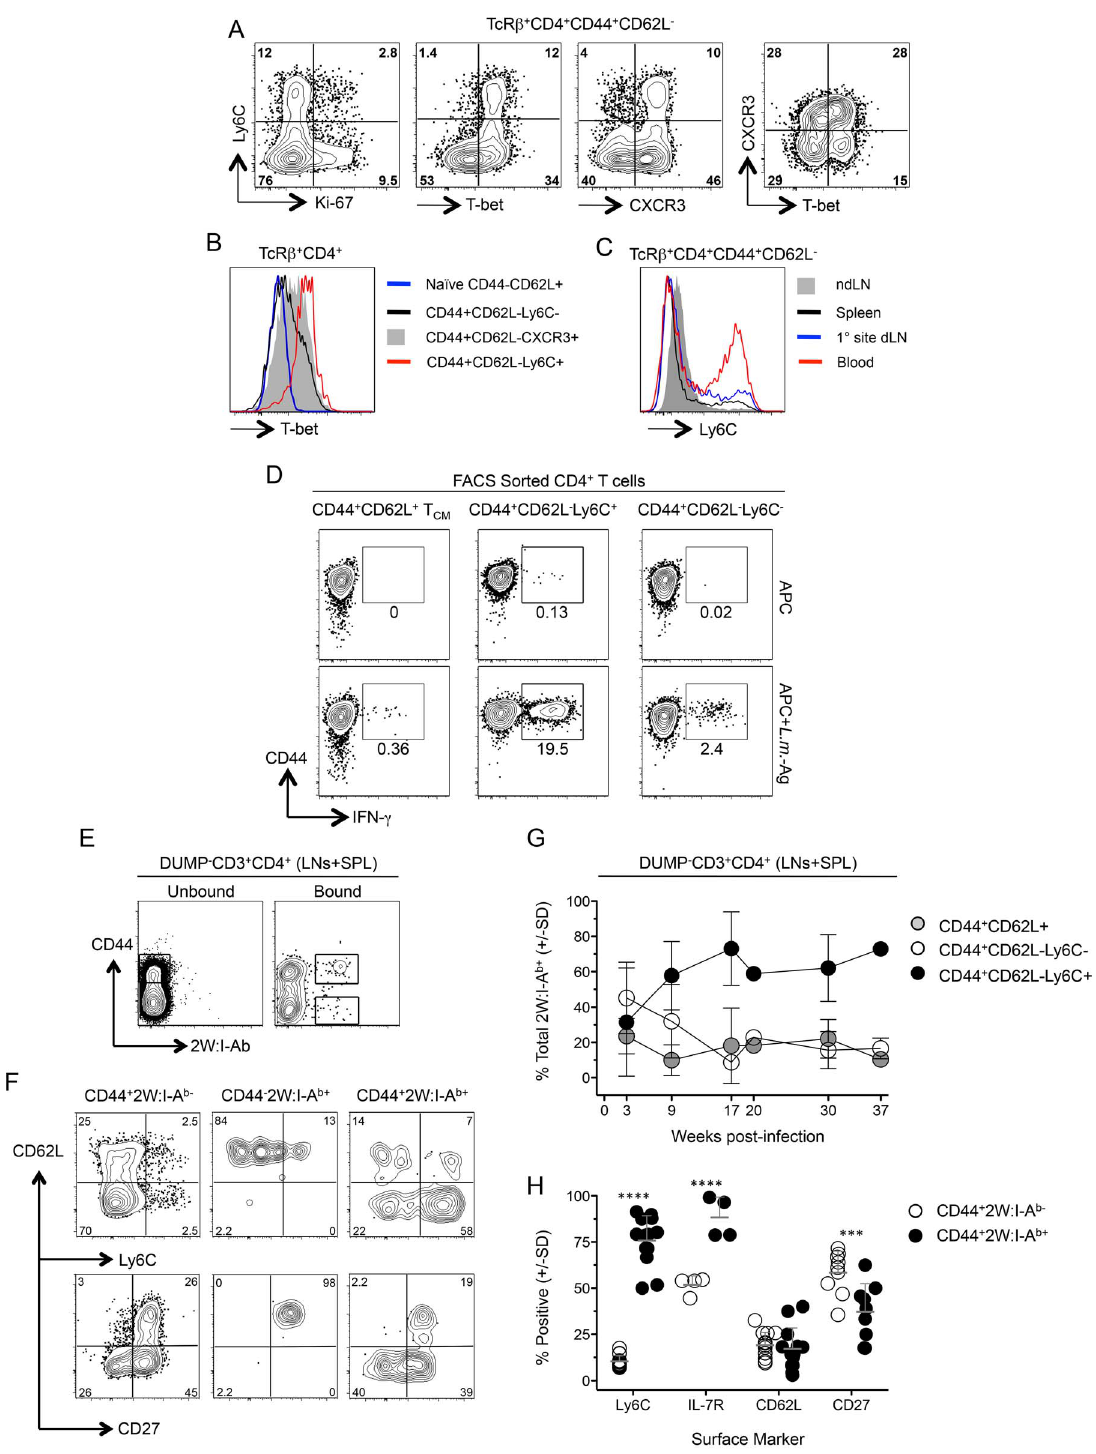
Figure 6. Ly6C hi T-bet hi CD4 + T cells exist prior to challenge and are the predominant phenotype of antigen-specific cells during chronic infection. ( A ) Representative FACS plots of Ly-6C, T-bet, Ki-67 and CXCR3 expression by polyclonal TCR b + CD4 + CD44 + CD62L 2 cells from the spleens of chronic mice. ( B ) Analysis of T-bet expression by the indicated polyclonal T cell populations ( C ). Ly6C expression on polyclonal TCR b + CD4 + CD44 + CD62L 2 cells from the spleen, dLN, ndLN or blood of chronic mice. Data in (A–C) are representative of two independent experiments. ( D ) Representative flow cytometry plots of CD44 versus IFN- c -staining of FACS sorted CD4 + CD44 + CD62L 2 Ly6C + , CD4 + CD44 + CD62L 2 Ly6C 2 or CD4 + CD44 + CD62L + T CM CD3 + CD4 + T cells from the spleen, dLN, ndLNs and blood of chronic mice following restimulation with APC alone or L.m. -Ag + APC. ( E–H ) 2W:I-A b -specific CD4 + T cells from the spleen, dLN and ndLNs of mice with a chronic primary L.m. -2W infection in the ear were magenetically enriched at the indicated time-points post-infection. Plots are gated on CD11b 2 CD11c 2 MHCII 2 F4/ 80 2 CD8 2 (DUMP 2 ) CD3 + CD4 + T cells. ( E ) Representative flow cytometry plot of CD44 versus 2W:I-A b staining on cells in the bound (Bound) or